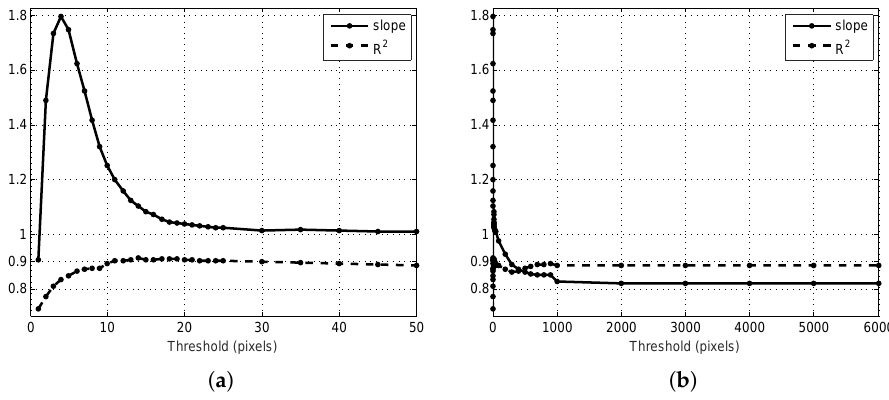
Figure 6. Performance of the algorithm for different threshold values: ( a ) in the region of reasonable values; ( b ) for ranges up to the size of the images. In both cases, values nearer to one indicate better performance. Higher R 2 values indicate better precision, and a slope nearer to one indicates better accuracy, compared to the harvest fruit counts for the 16 target